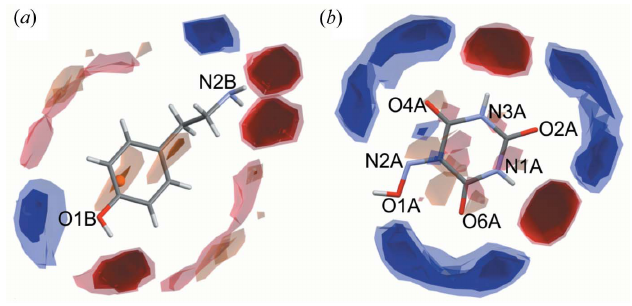
Figure 1 Full interaction maps of ( a ) TYR and ( b ) VA. Blue denotes possible donor sites, whereas red denotes possible acceptor